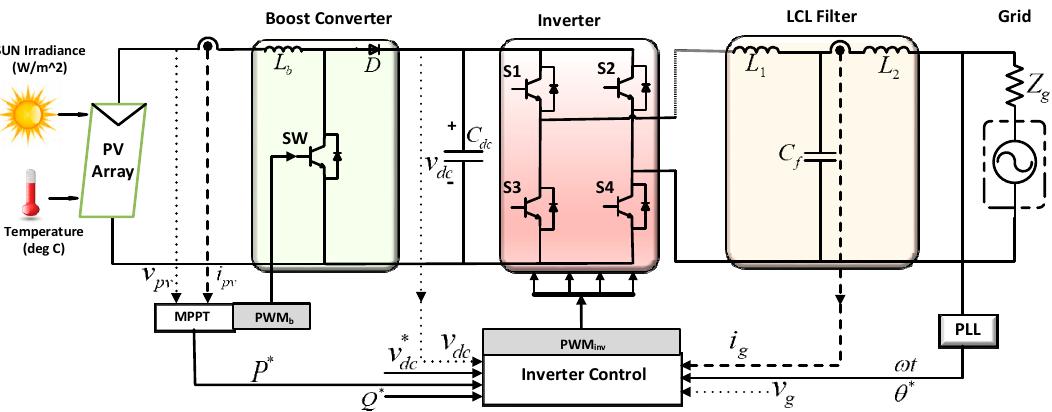
Figure 1. A two-stage single phase grid-connected PV system with an LCL filter. Table 1. Rated parameters of the 3 kW grid-connected photovoltaic model.